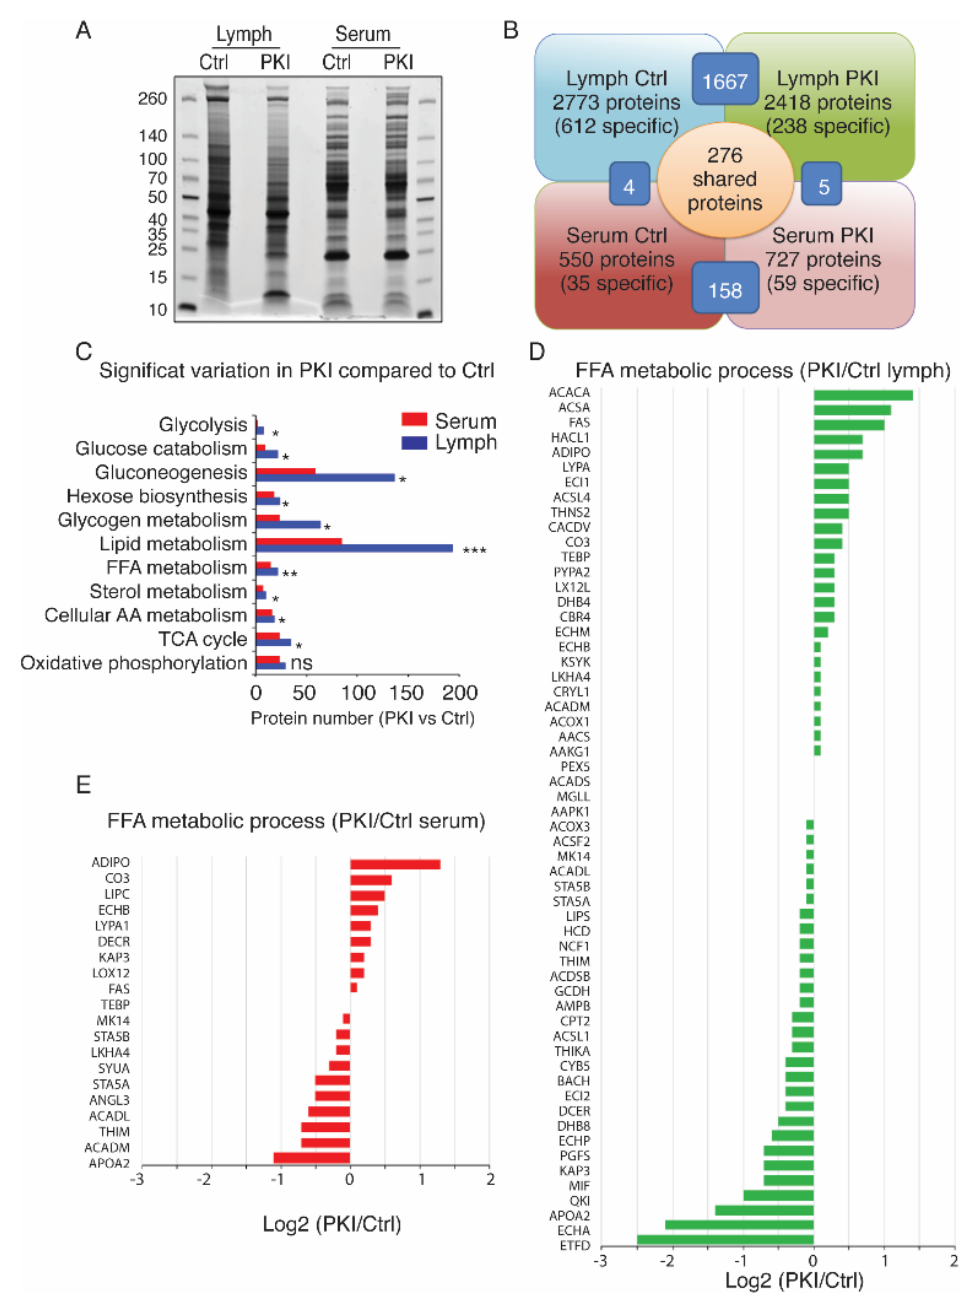
Figure 4. Proteomic analysis of the lymph and serum from tumor-bearing mice. ( A ) Lymph and serum peptides profile analysis in control and PKI mice after equalization. ( B ) Identified protein repartition in lymph and serum samples. ( C ) Mass spectrometry analysis of the lymph and serum from PKI mice exhibit significant changes in protein level in lymph compared to serum, in particular in proteins involved in the lipid metabolism process (mean + sem; n = nine animals; * p < 0.05, ** p < 0.01, *** p < 0.001). ( D ) Analysis of proteins involved in FFA metabolic process changes in lymph from PKI mice compared to control mice. ( E ) Analysis of proteins involved in FFA metabolic process changes in serum from PKI mice compared to control mice.